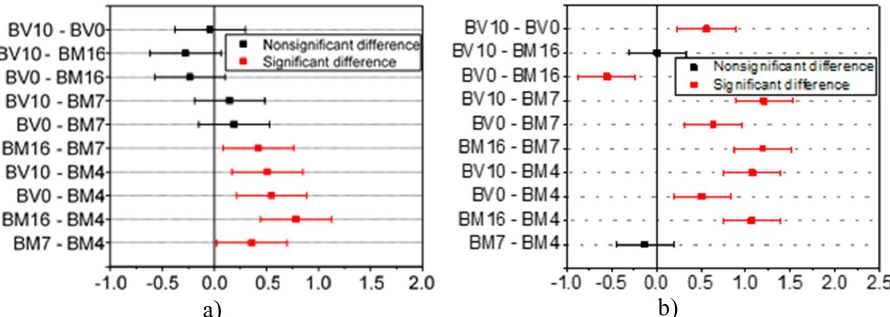
Figure 13. Tukey test for the push-out results (mean comparison).